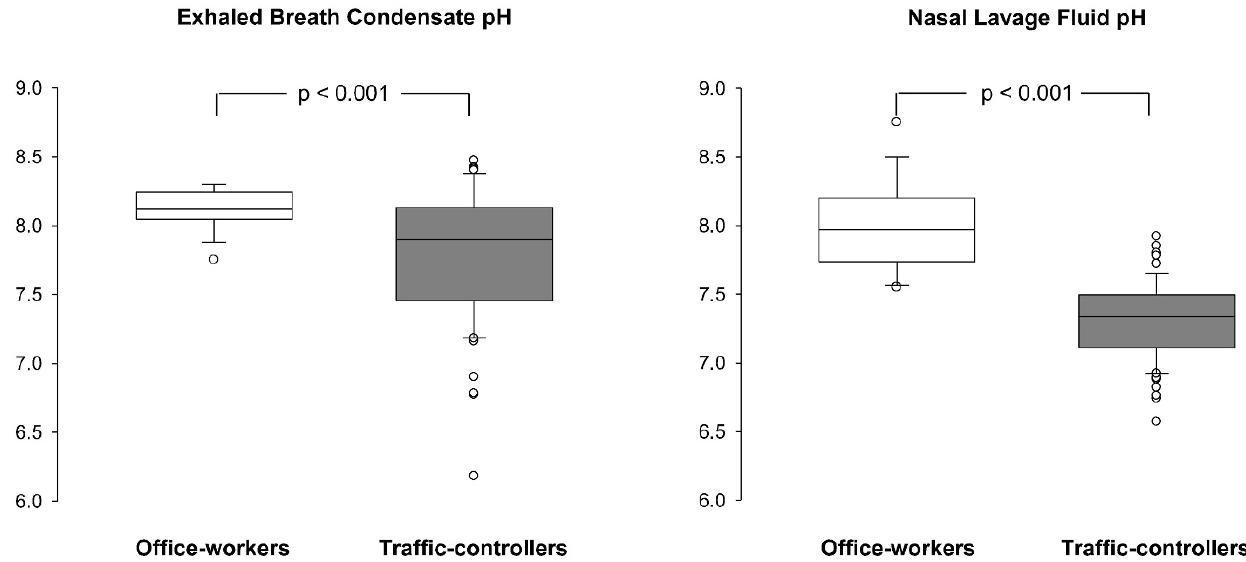
Figure 1 - The pH of the exhaled breath condensate and nasal lavage fluid of the traffic-controllers and office-workers.